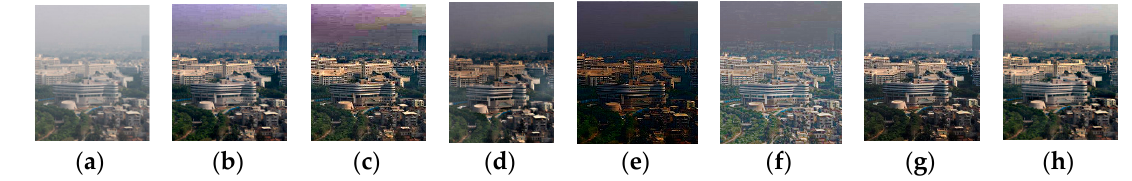
Figure 16. Qualitative comparison on hazy image with large sky region. ( a ) Hazy image with large sky region. ( b ) He et al.’s result. ( c ) Meng et al.’s result. ( d ) Ancuti et al.’s result. ( e ) Yu et al.’s result. ( f ) Tarel et al.’s result. ( g ) Choi et al.’s result. ( h ) Our result.